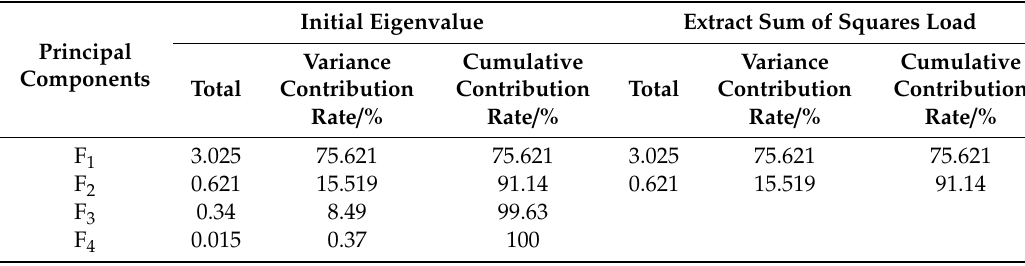
Table 5. Total variance contribution by components.